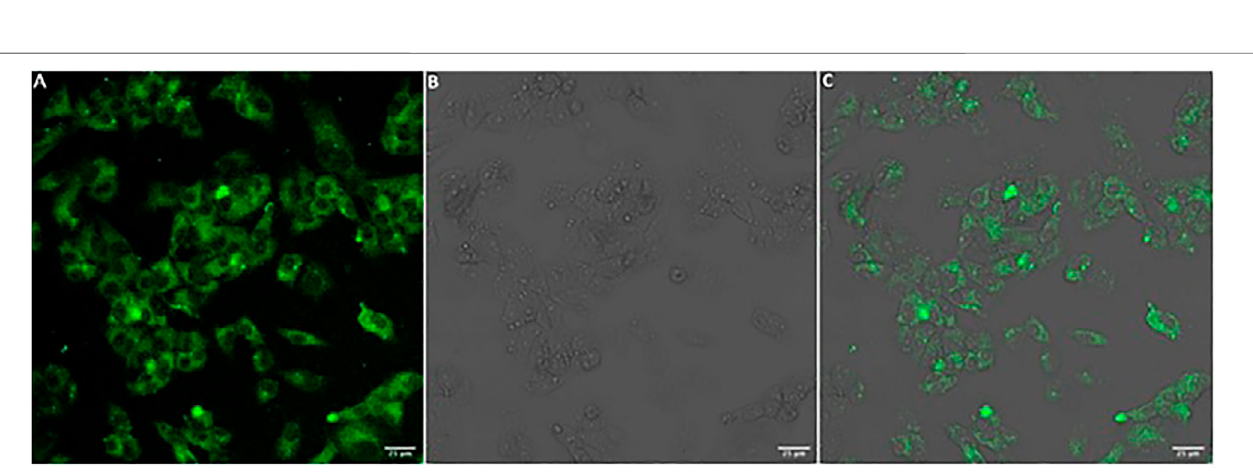
FIGURE 4 | HepG2 cellular introduction of liposomal DPTZ-DBTO2 under 24 h incubation with 20% v/v PD-10 column separated liposomes from fraction 1, with liposomes 100 nm in diameter. Confocal microscopy images for (A) DPTZ-DBTO2 emission, (B) bright fi eld and (C) DPTZ-DBTO2 emission and bright fi eld overlaid. Scale bar (bottom left, white rectangle) 25 μ m in length. See text for details.